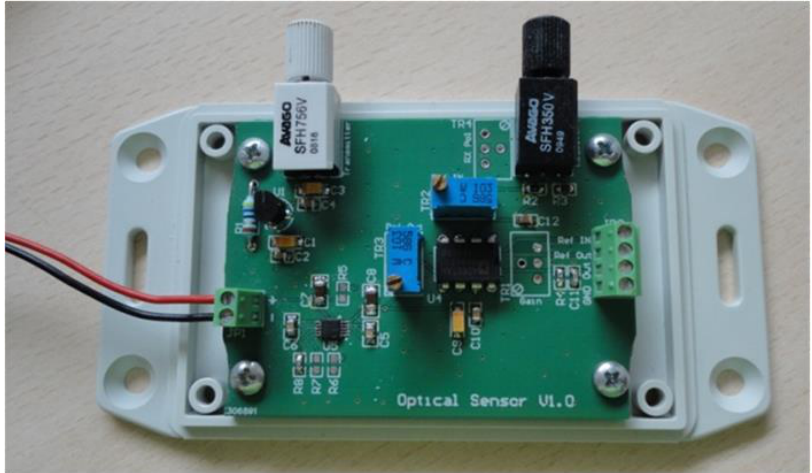
Figure 12. Prototype development of the Fiber Optic Driving Circuit Board. Integration of the LED source and the photodetector in the same battery operated PCB-board.